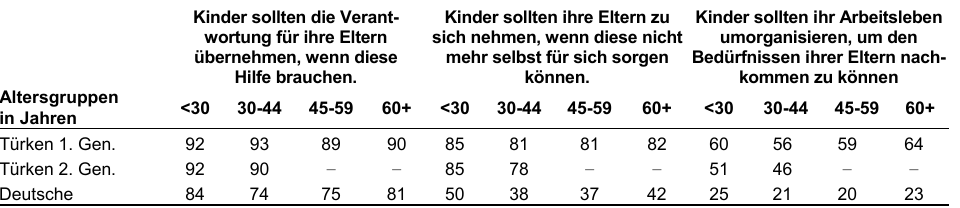
Tabelle 1 : Anteil der Zustimmung (nur: stimme [sehr] zu) nach Altersgruppen (%) Kinder sollten die Verant- wortung für ihre